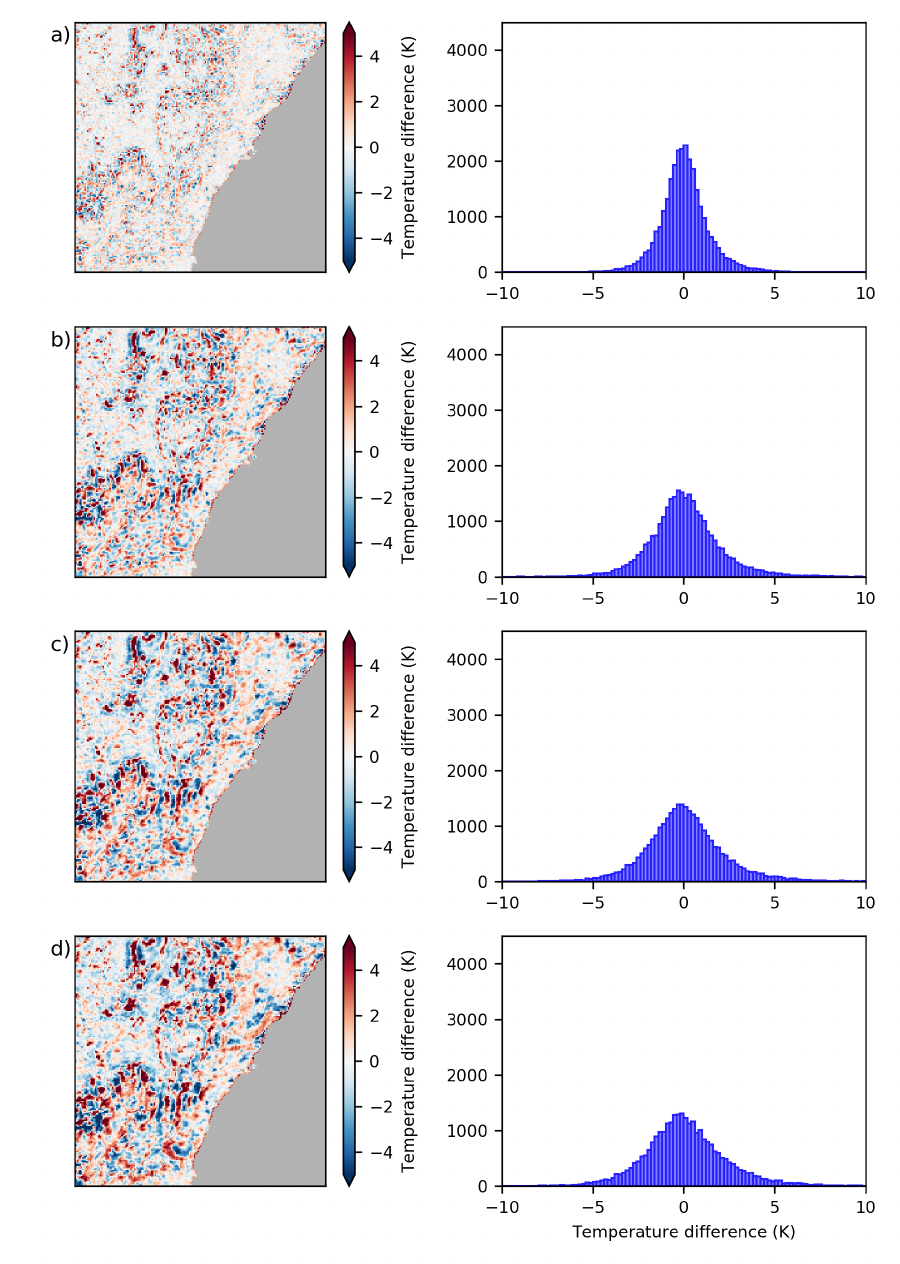
Figure 8. Changes in the spatial and statistical distribution of temperature estimates for the south-eastern Australia (sea) study area by window size. Window levels shown are ( a ) 5 × 5 window; ( b ) 7 × 7 window; ( c ) 9 × 9 window; and ( d ) 11 × 11